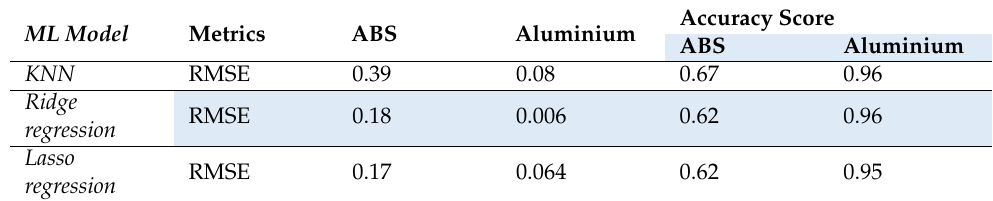
Table 3. The performance metrics for selected machine learning